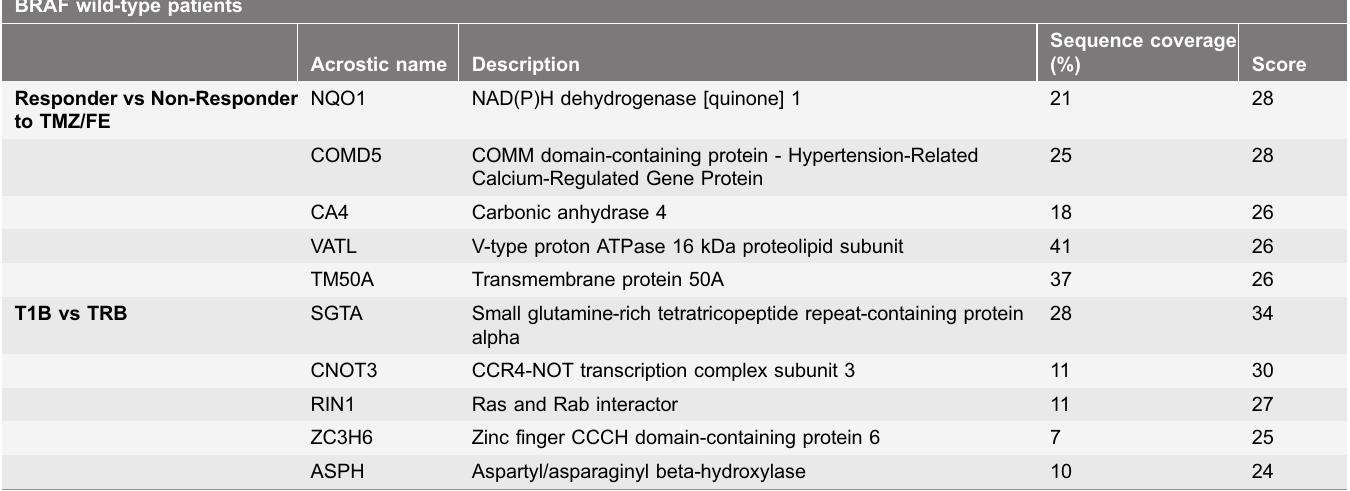
Table 6. Mascot search result for BRAF wild-type patients. BRAF wild-type patients